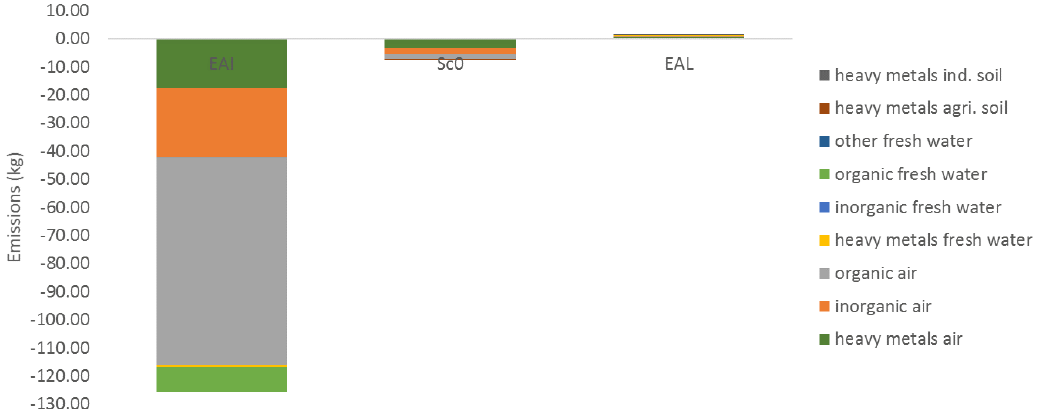
Figure 11. Human toxicity comparison for the reference case (Sc0) among average European scenarios. Results refer to one tonne of treated residues.